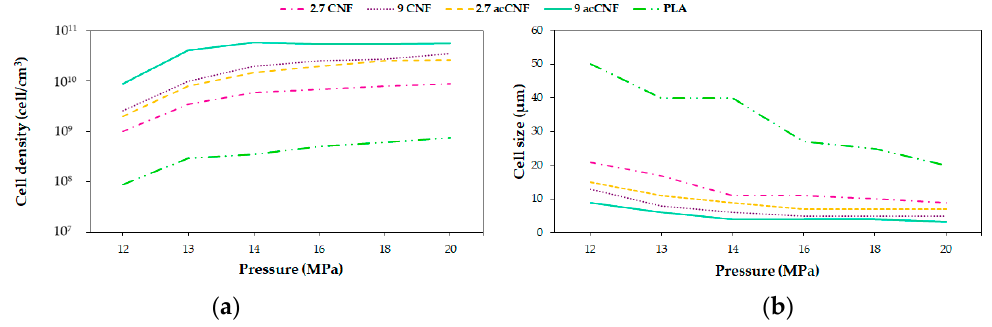
Figure 14. Effect of variations in pressure on the ( a ) average cell diameter and ( b ) cell density of the neat PLA and PLA/aCNFs nanocomposite foams. Data taken from Dlouhá et al. [126].